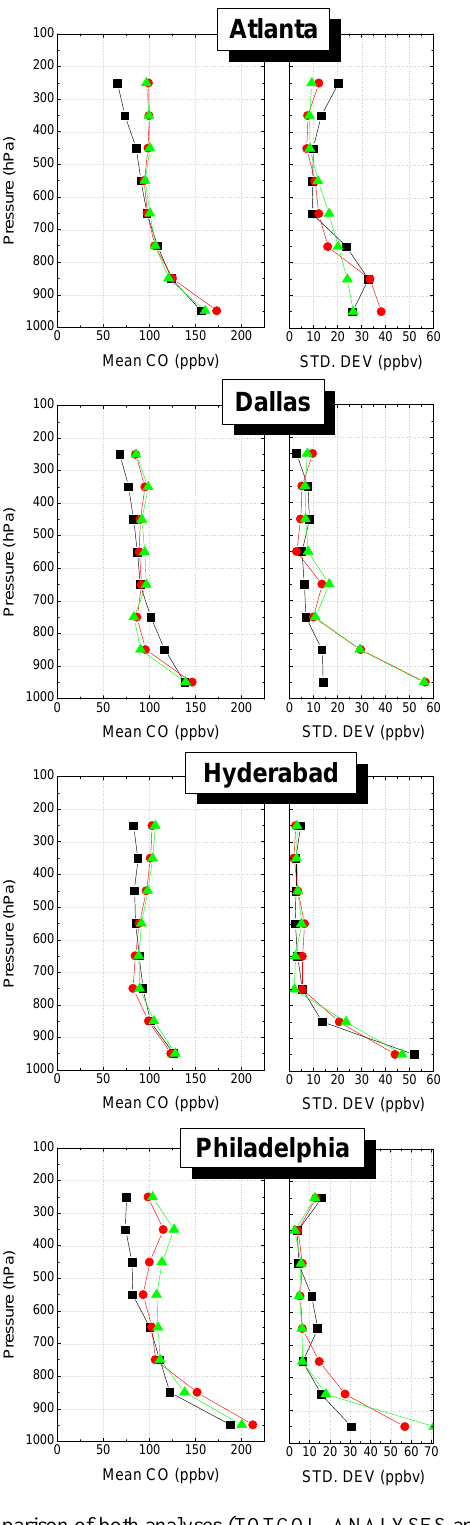
Figure 17. Comparison of both analyses (TOTCOL_ANALYSES and PROFILE_ANALYSES) with MOZAIC in terms of vertical profiles. Black: MOZAIC. Red: analyses of MOPITT V3 profiles (taking into account averaging kernels, covariance error matrices and a priori profile). Green: analyses of MOPITT V3 total columns for which the error specification was done following the χ 2 test (see Sect. 3.) Atmos. Meas. Tech., 7, 3035–3057,